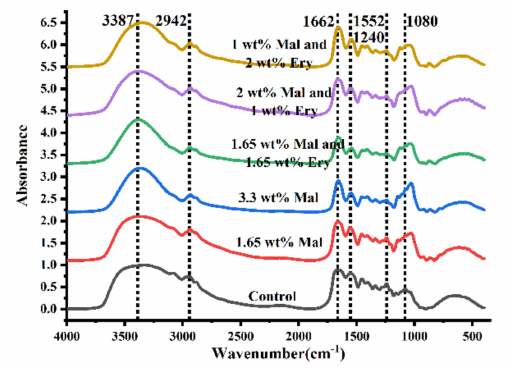
Figure 7. The FTIR spectra of maltitol, erythritol, gelatin and low acyl gellan gel with different maltitol and erythritol content.